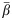
Quantitative features of RNA crosstalk in the CLASH interactome derived by solving Eq (6).(a) Representative distributions of susceptibilities obtained for the CLASH interactome for five different realizations of parameters with different values of β¯, CVtr = 0.4 and maximal BH. (b) Mean susceptibility (averaged over pairs of distinct RNAs and over 100 independent realizations of TH) as a function of the mean miRNA transcription rate β¯. (c) Mean maximal susceptibility (computed over all pairs of distinct RNAs and averaged over 100 independent realizations of TH) as a function of the mean miRNA transcription rate β¯. Results are shown for the 3 BH scenarios considered. Parameter values are reported in Table 1. The yellow shaded area qualitatively marks the region where the mean susceptibility is significantly different from zero, which coincides with the susceptible regime [18]. In each case, the standard error of the mean is equal to or smaller than the size of the markers.